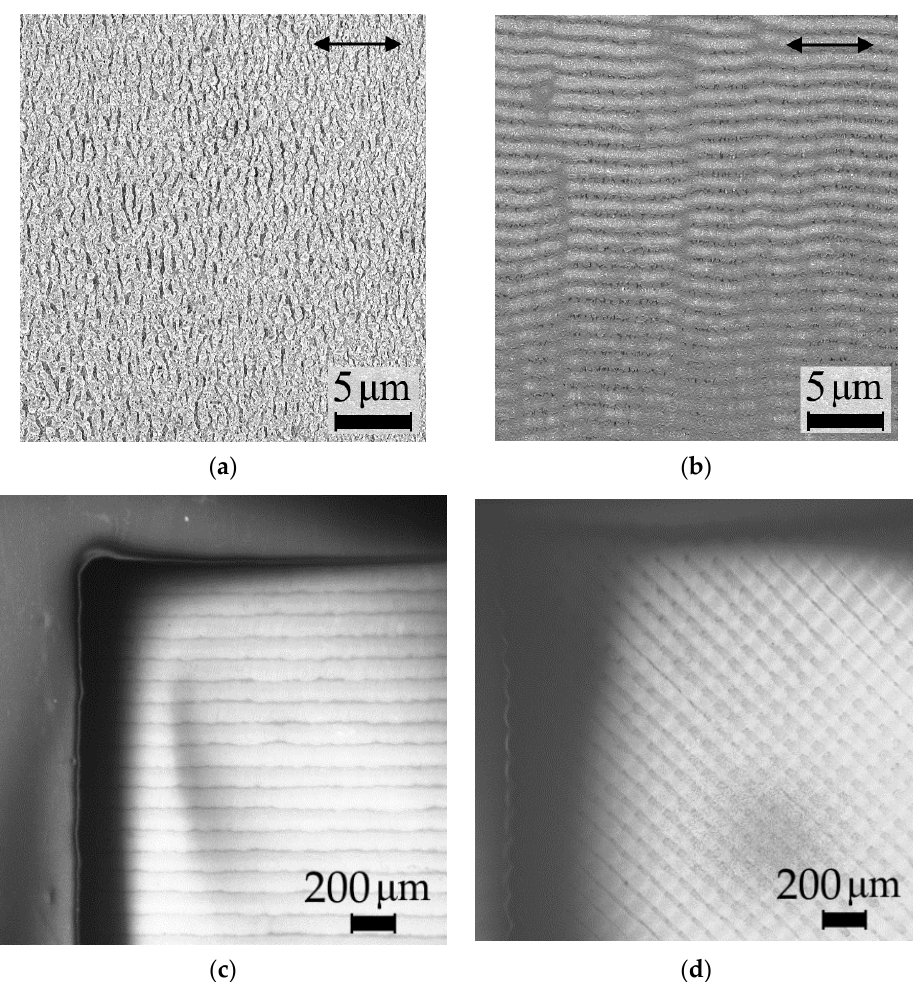
Figure 2. Images of femtosecond laser-modified surfaces of ( a ) sample 1 and ( b ) sample 2, obtained by SEM at 5000× magnification. The arrows indicate the polarization of the femtosecond laser pulses. SEM images of femtosecond laser-modified surfaces of ( c ) sample 1 and ( d ) sample 2, obtained at 70× magnification.